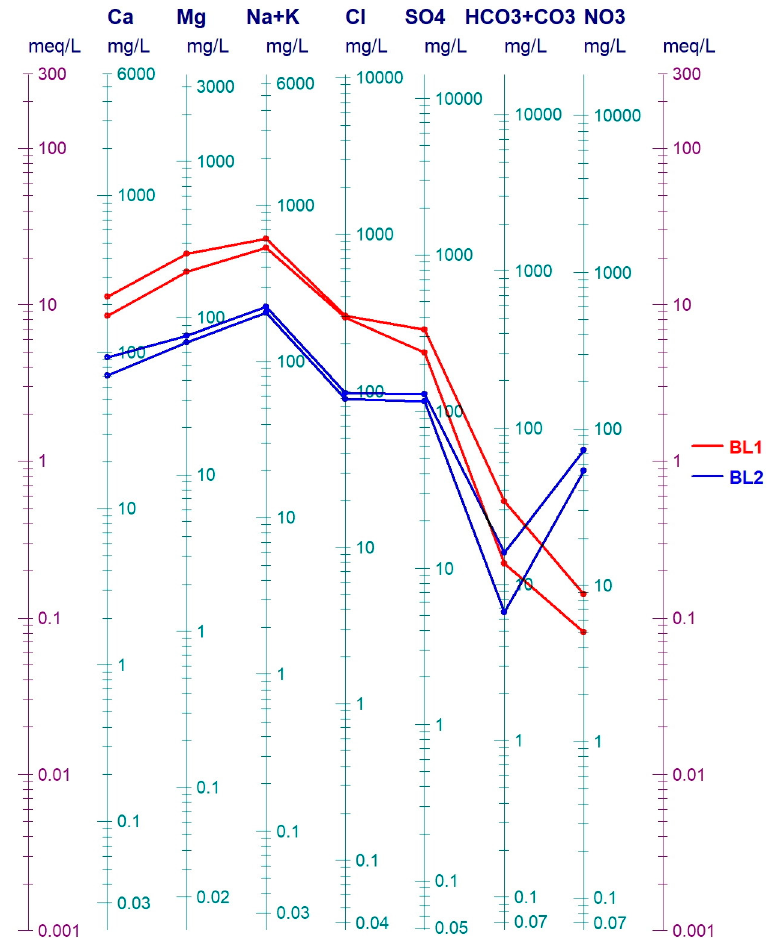
Figure 10. Major cation and anion values of water samples from BL1 and BL2 monitoring wells in the summer and autumn of 2020.